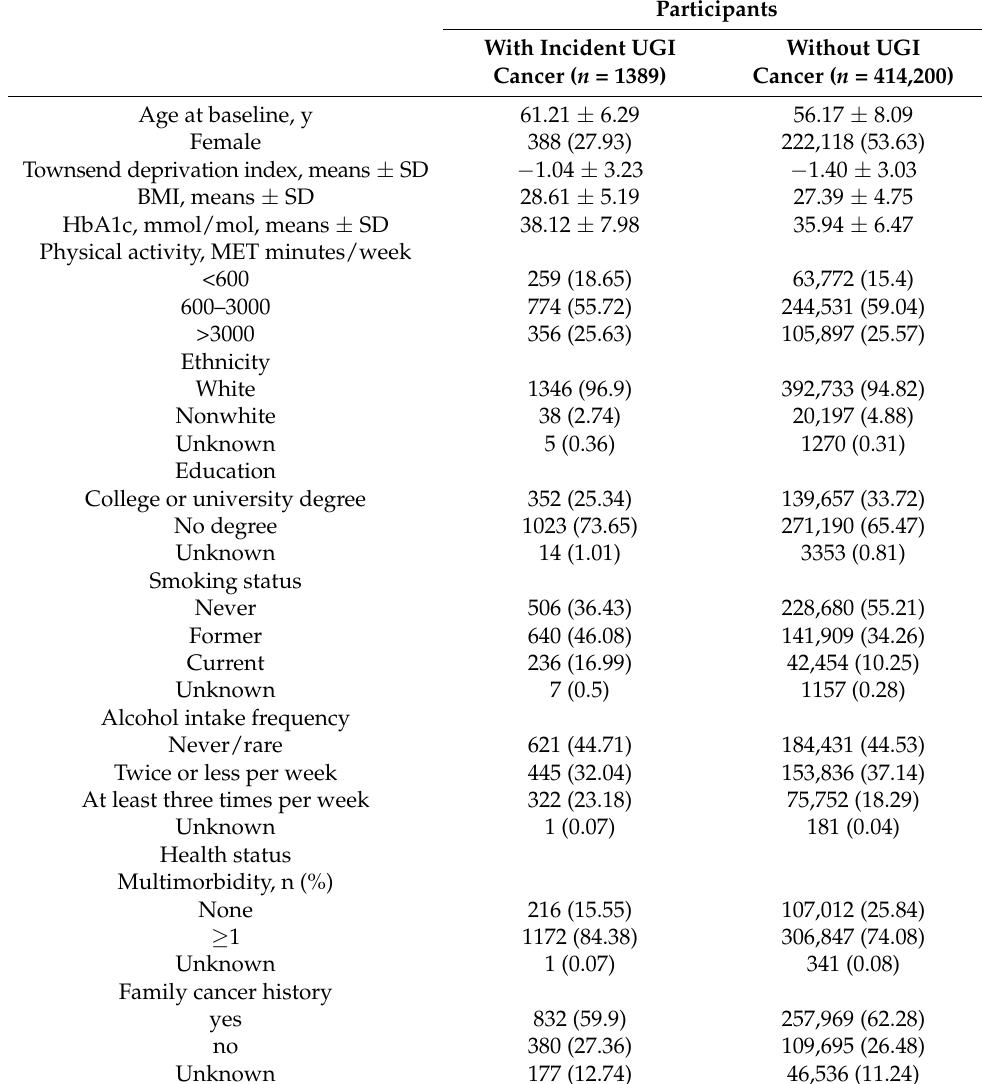
Table 1. Baseline characteristics of participants in UK Biobank 1 .